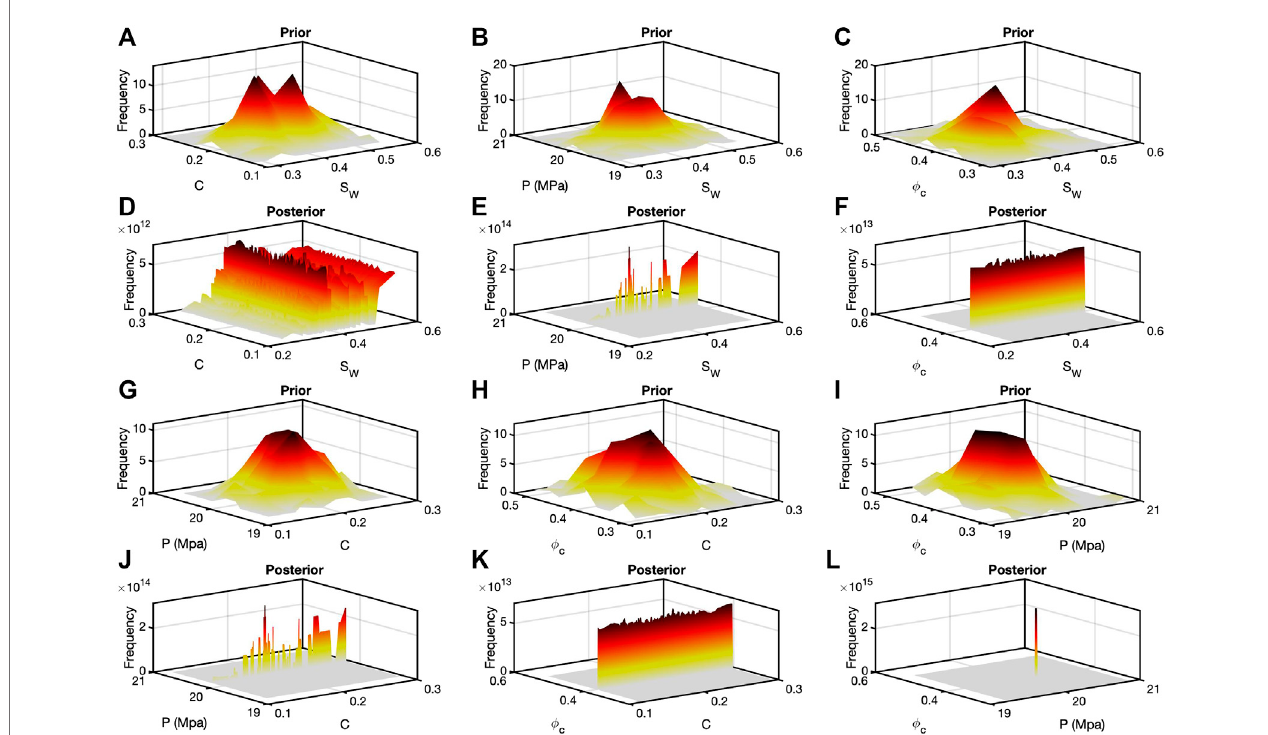
FIGURE7| Results from anallysis three forgassands displayed again asbivariate priorand posteriorhistograms. Thelayout isidentical to Figure 5 .The priorwas different from inversions one and two including different fl uid properties of gas relative to oil. However, the posterior histograms, in particular (D) and (L) , resemble their counterparts in Figures 5, 6 .